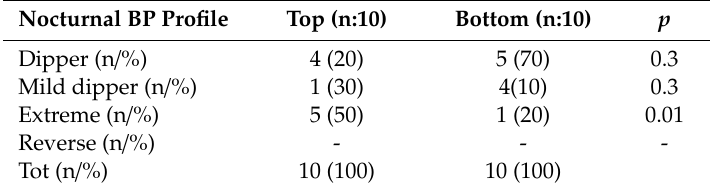
Table 6. Nocturnal dipping patterns—asthmatics top vs. bottom levels of FEV 1.